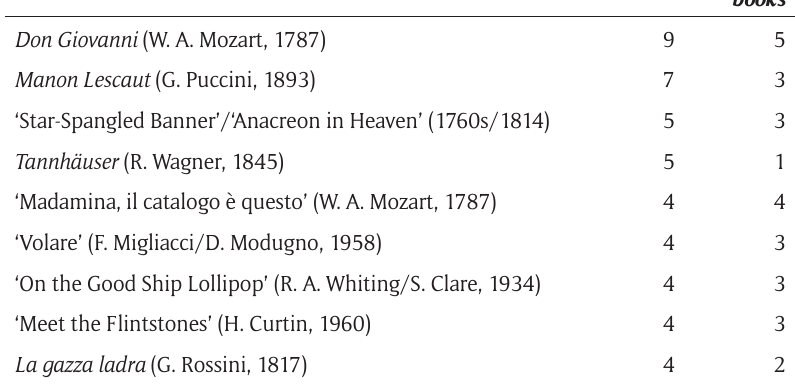
Table 3: Most frequently referenced works of